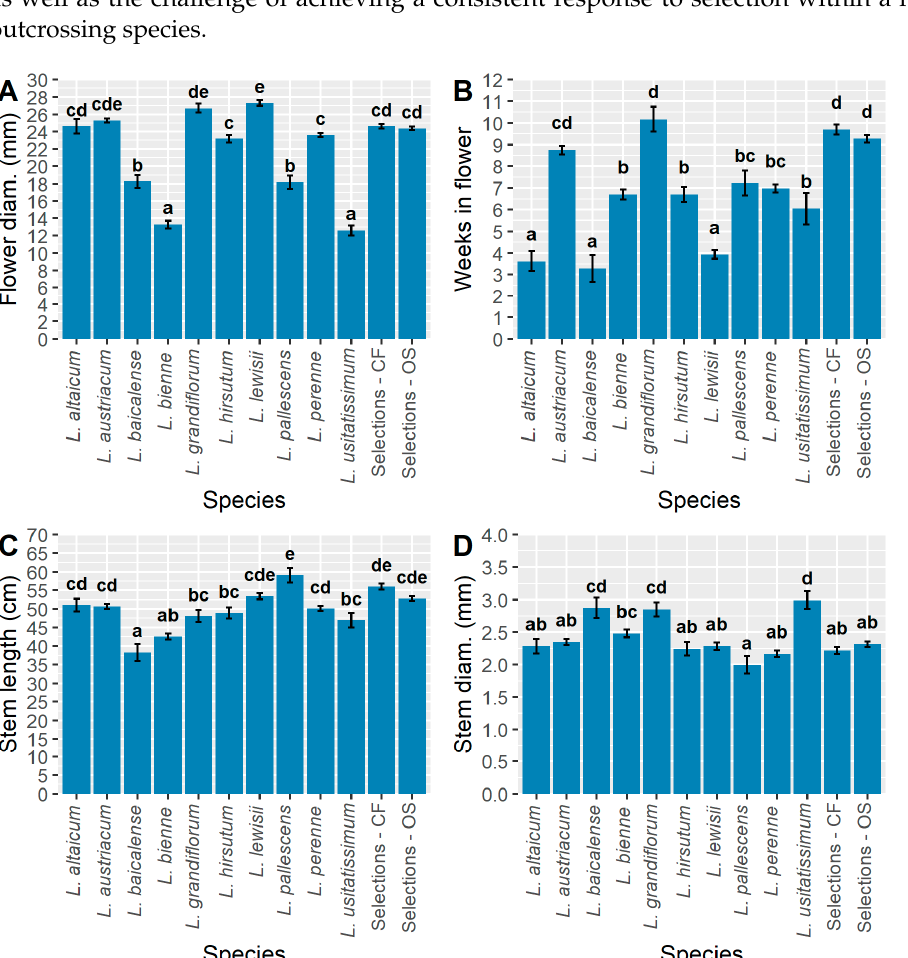
Figure 1. Comparison of wild flax species with CF and OS selections for mean ± S.E. year one trait values related to the CF ideotype: ( A ) flower diameter (mm), ( B ) number of weeks in flower, ( C ) stem length (cm), and ( D ) stem diameter (mm). Mean separations (5% HSD) are displayed as letters above the columns denoting significance.